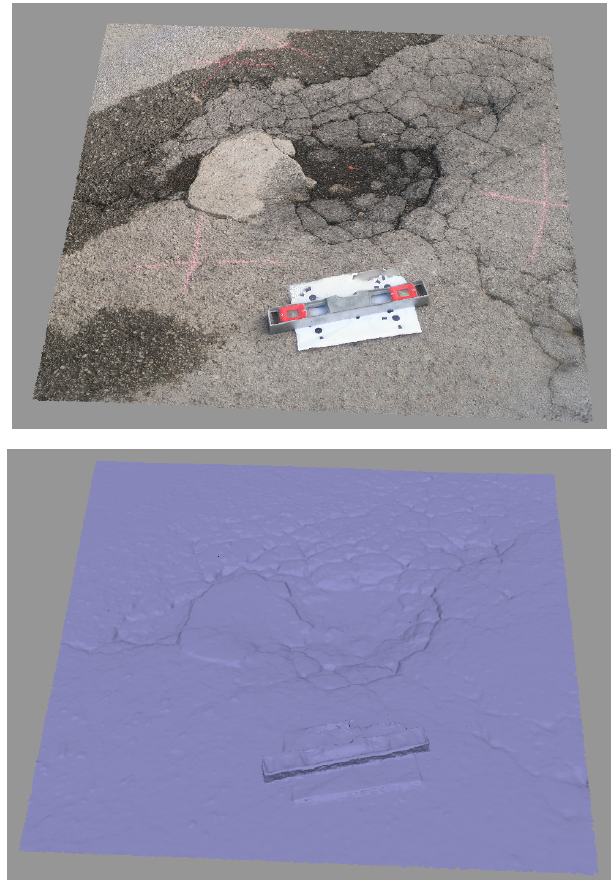
Figure 10. Model of distress 2—( top ) and dense cloud—( bottom ) produced by Huawei P20 Pro imagery.